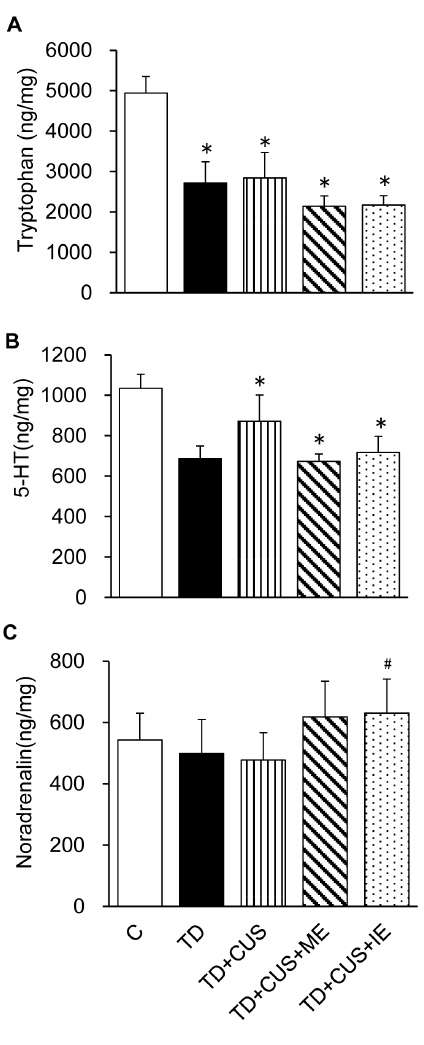
Figure 3. Effects of tryptophan deficiency, CUS and regular exercise on the levels of tryptophan (a), 5-HT (b) and noradrenaline (c) in the hippocampus. Data are expressed as mean 6 SEM. * , p , 0.05 vs. C; # , p , 0.05 vs. C, TD, TD +